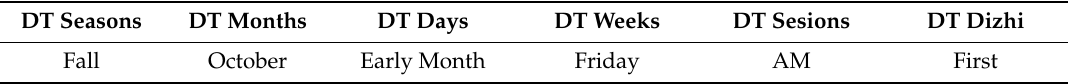
Table 2. Example-semantic meaning at the time